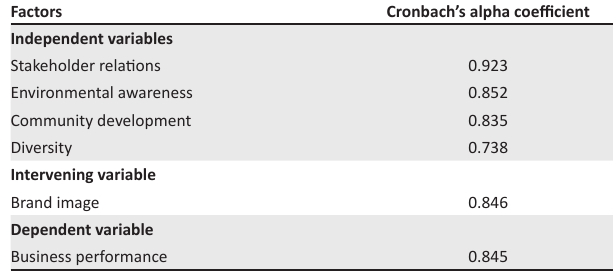
TABLE 3: Cronbach’s alpha coefficients